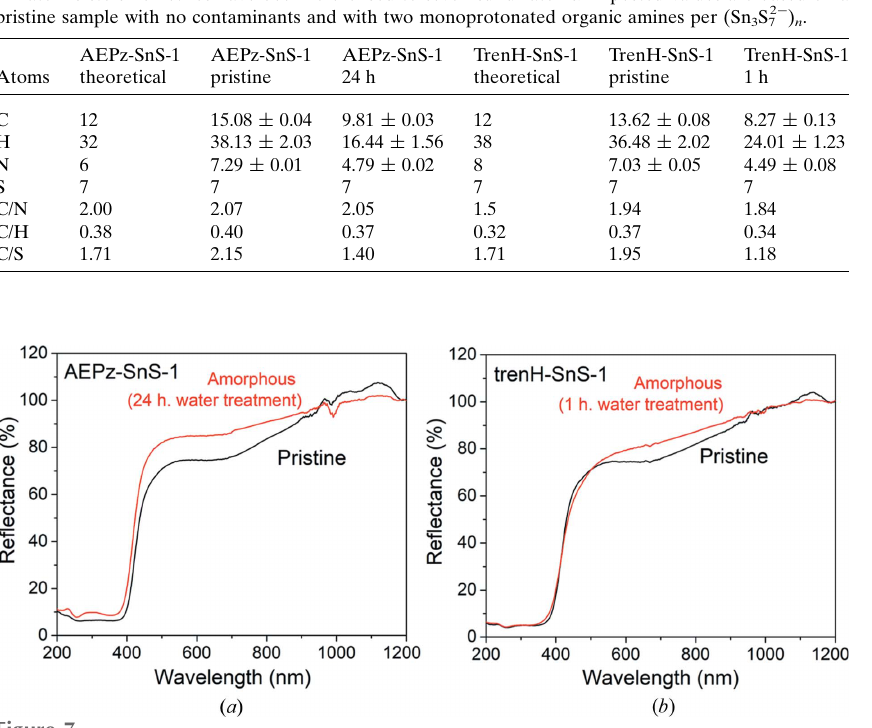
Figure 7 Diffuse reflectance spectra of pristine and amorphous ( a ) AEPz-SnS-1 and ( b ) trenH-SnS-1.